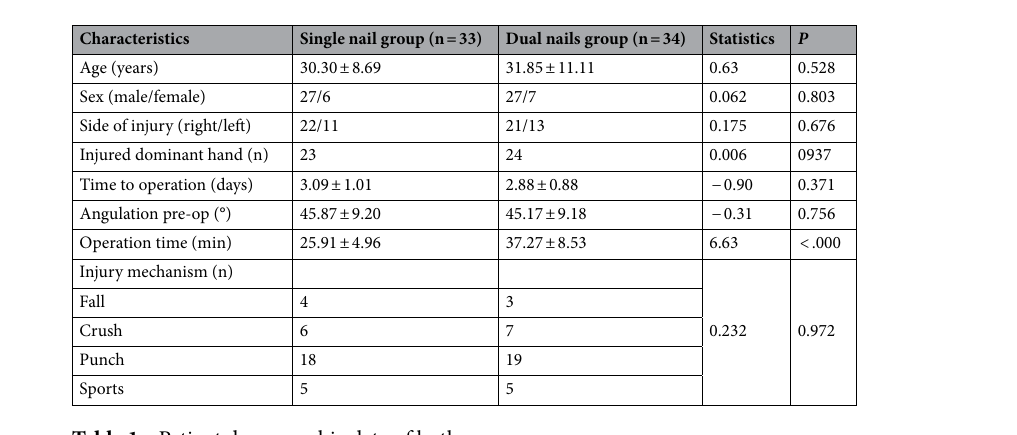
Table 1. Patient demographic data of both